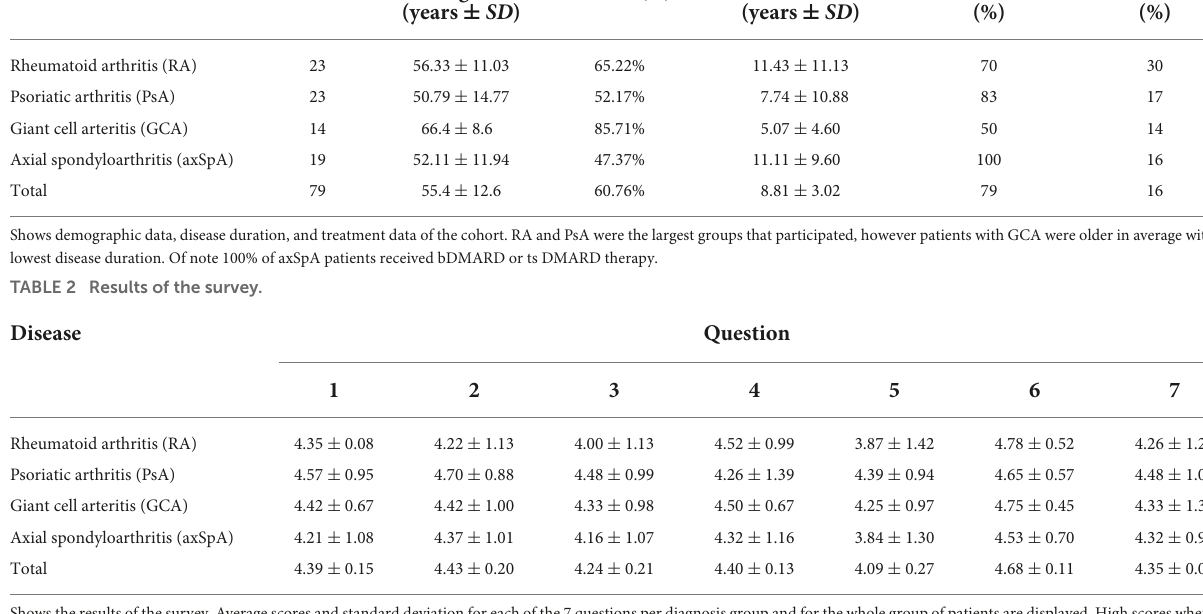
TABLE 1 Demographic data, disease duration and treatment. Disease